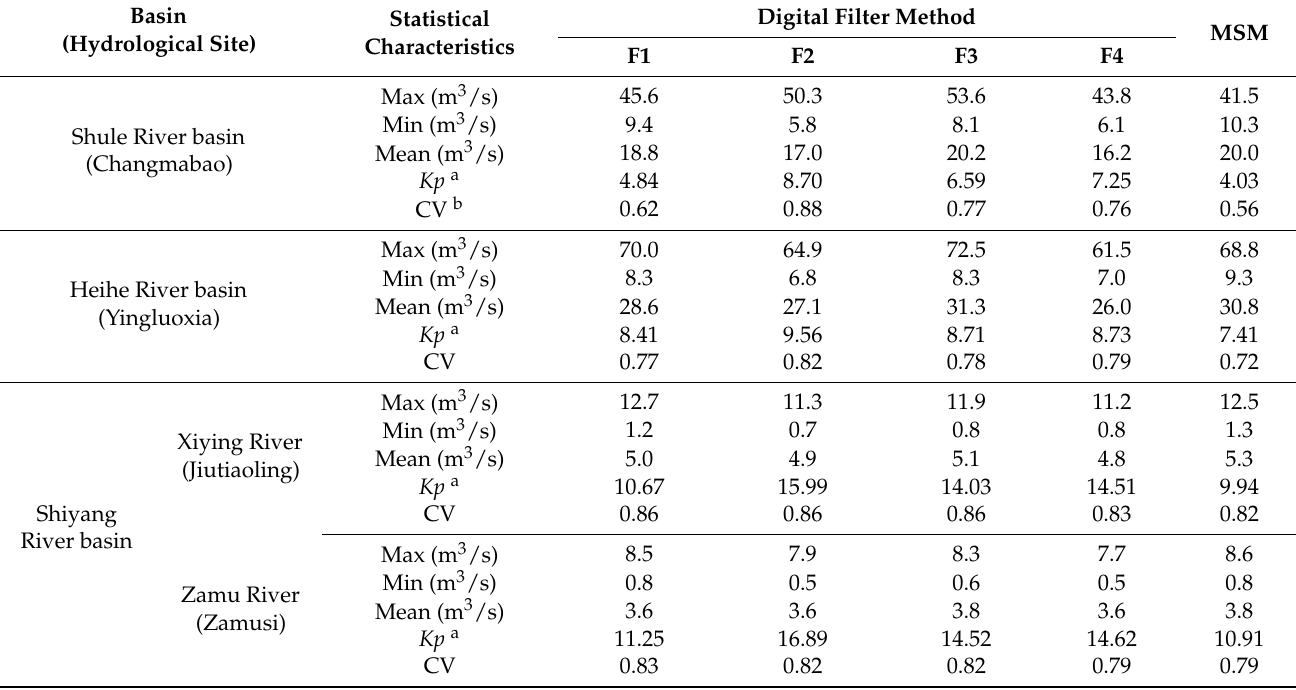
Table 2. Statistical characteristics of the intra-annual base flow in the base flow separation methods applied to the Hexi inland rivers basin. ( Kp , the extreme value